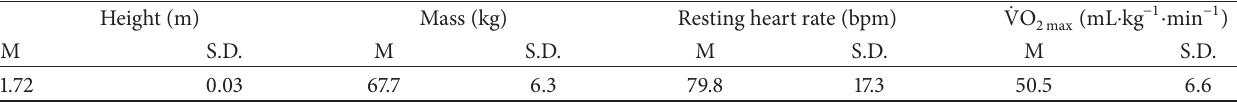
Table 1: Descriptive information (mean ± S.D.) of participants’ height, body mass, resting heart rate, and maximal oxygen